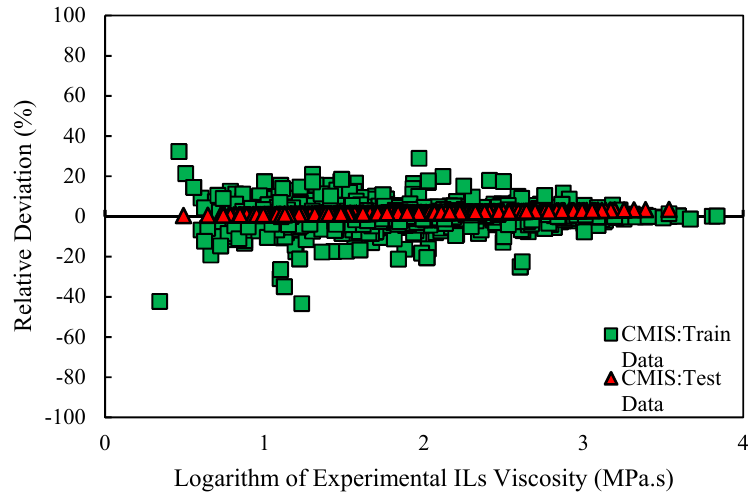
Figure 6. Relative deviation of prediction of CMIS model versus logarithm of experimental data based on Model (II).